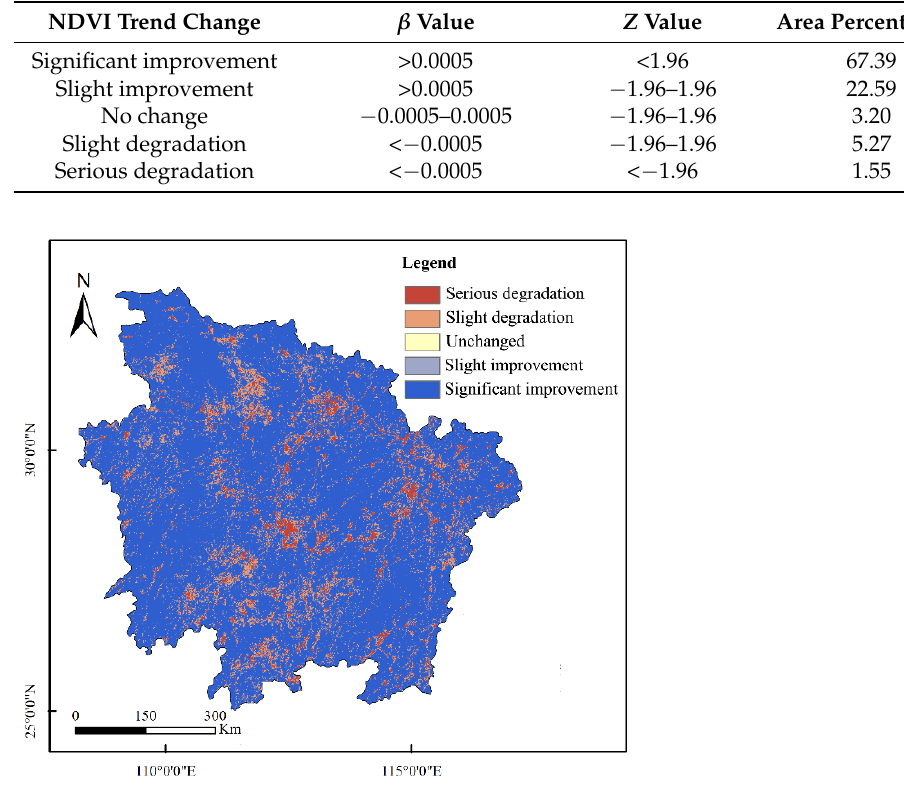
Figure 4. Trends of vegetation NDVI in the middle reaches of the Yangtze River (MRYR) from 1999 to 2015.